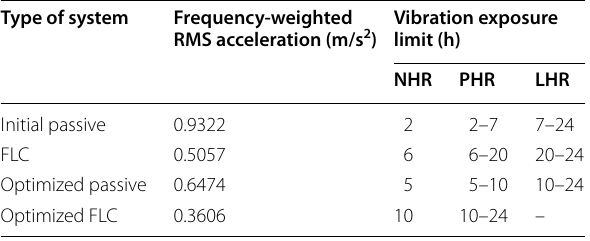
Table 4 Time limits as per Health Guidance Caution Zone (HGCZ) as per ISO—2631-1 Type of